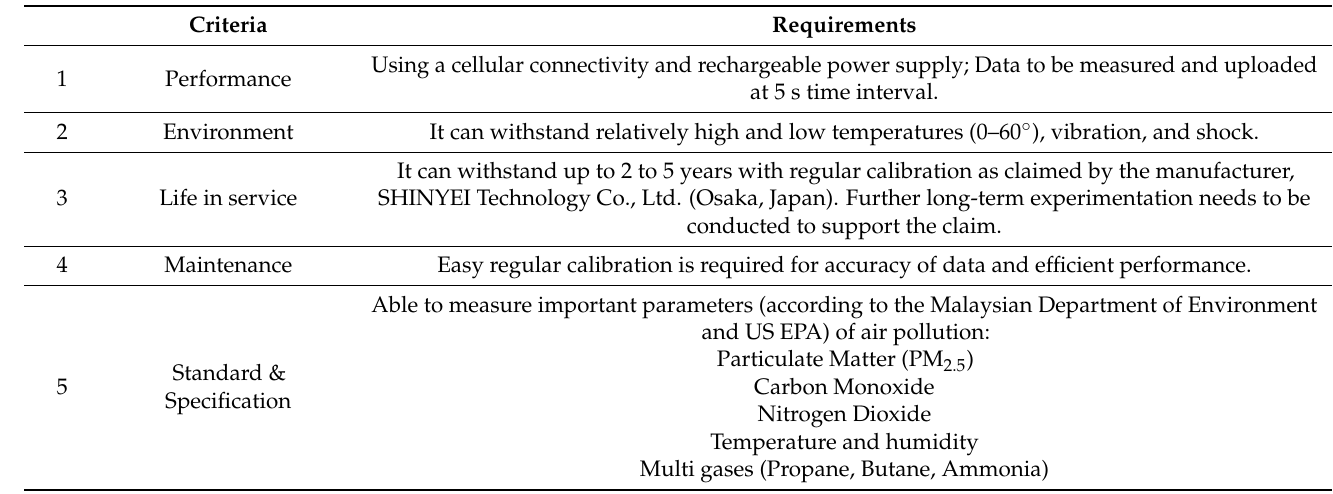
Table 2. PDS for the individual outdoor exposure indicator using wireless